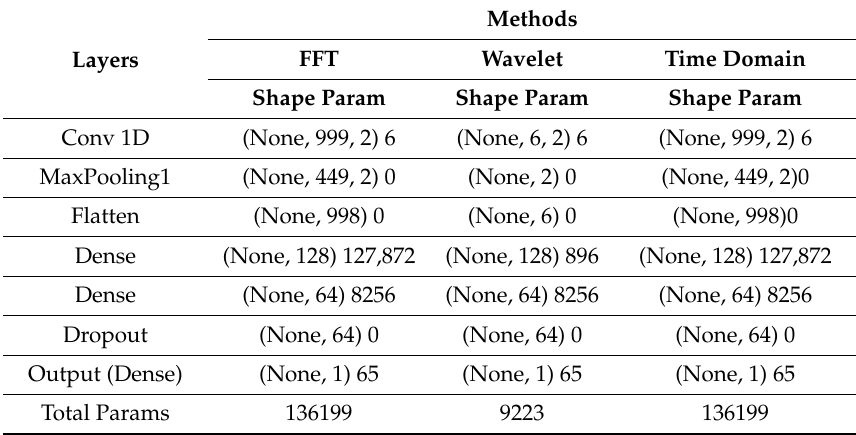
Table 7. Impact of the di ff erent parameters on the